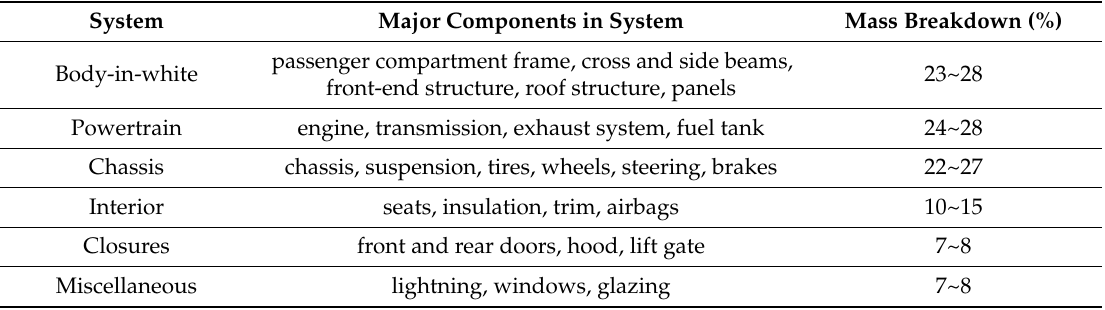
Table 1. Mass proportion of vehicle systems and components